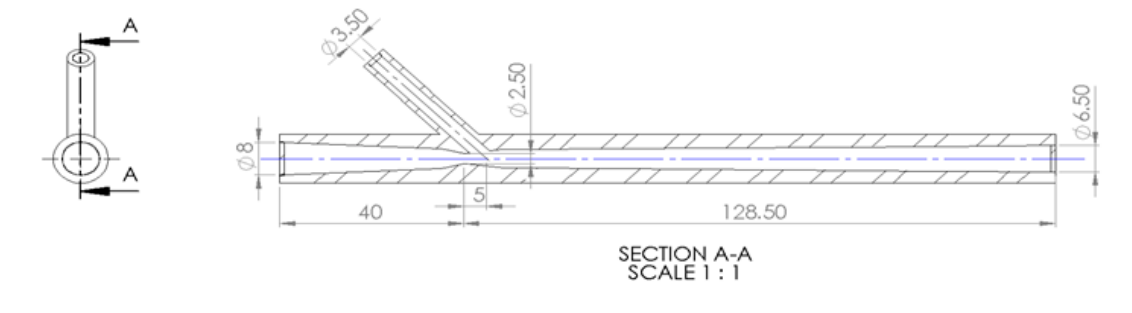
Figure 2. Geometry of the nozzle.